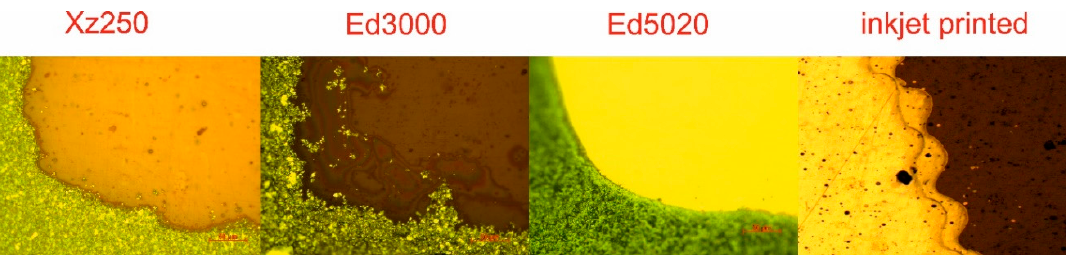
Figure 9. The edges of the realized UWB antenna by screen-printing with the 400 mesh and inkjet- printing technology.